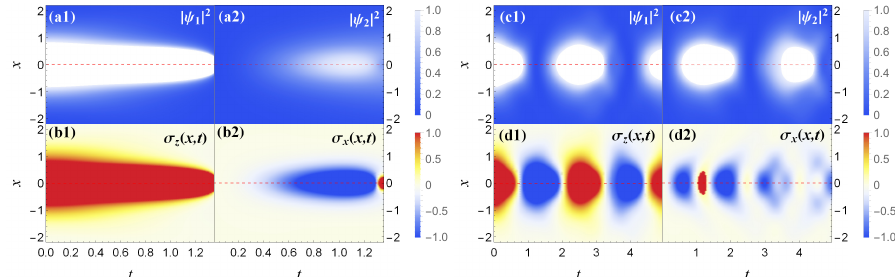
Figure 3. The density plot of the condensate parameters taken from panels ( a , b ) of Figure 2 is presented for the corresponding values of ( gN , Ω ) . The panels ( a1 , c1 ) are demonstrating | ψ 1 | 2 and ( a2 , c2 ) are demonstrating | ψ 2 | 2 . The panels ( b1 , d1 ) are demonstrating σ z and ( b2 , d2 ) are demonstrat- ing σ x . The plots are presented in the plane ( x , t ) for intra-spin interaction κ = − 1 in Equation (1). The values of ( gN , Ω ) are given from the points (1, 2) of the Figure 1, correspondingly, for collapsing and stable BEC. The density scales on the right side are the same for all panels with arbitrary units. Here the panels ( a , b ) are presenting collapse of the first spin component with corresponding spin dynamics and the panels ( c , d ) are presenting stable condensate with total density transition between spin components and corresponding spin